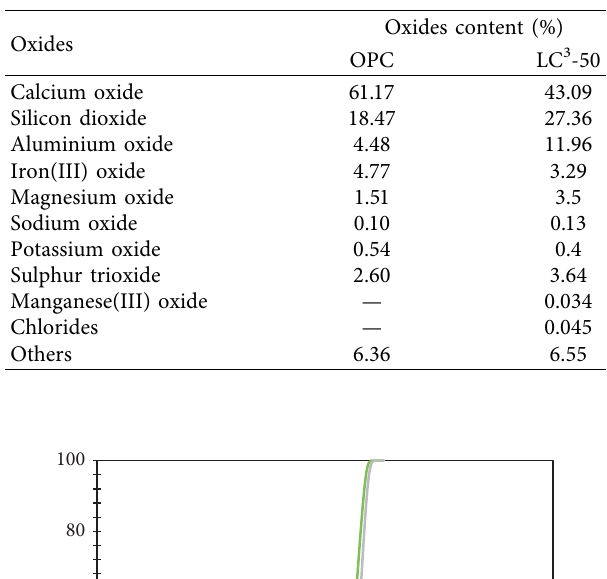
Table 1: Chemical composition of OPC and LC 3 -50.